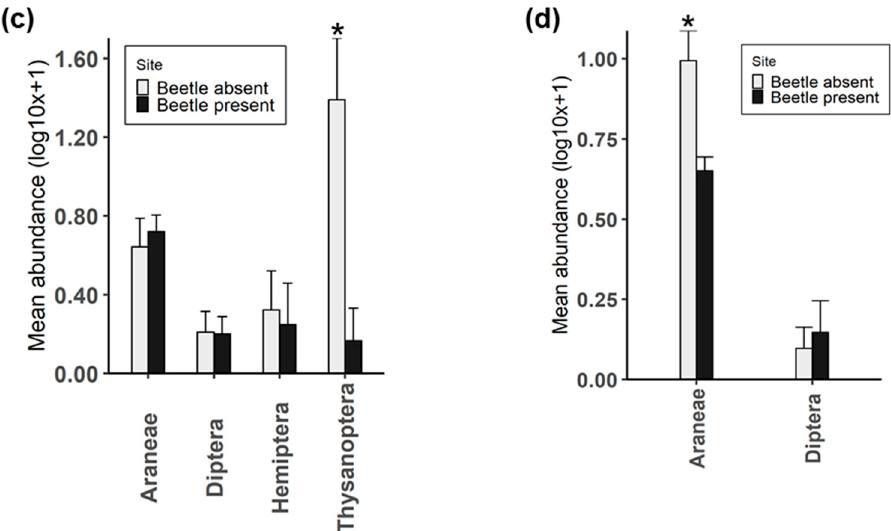
Figure 6. Comparing the abundance of arthropods other than L. suturalis on heather between sites. Samples collected on ( a ) November 2018, ( b ) December 2018, ( c ) January 2019 and ( d ) March 2019 using the beating tray technique (n = 3). Bars show mean ± SE and asterisk indicates a significant di ff erence between sites. Asterisk indicates significant di ff erences (* p <